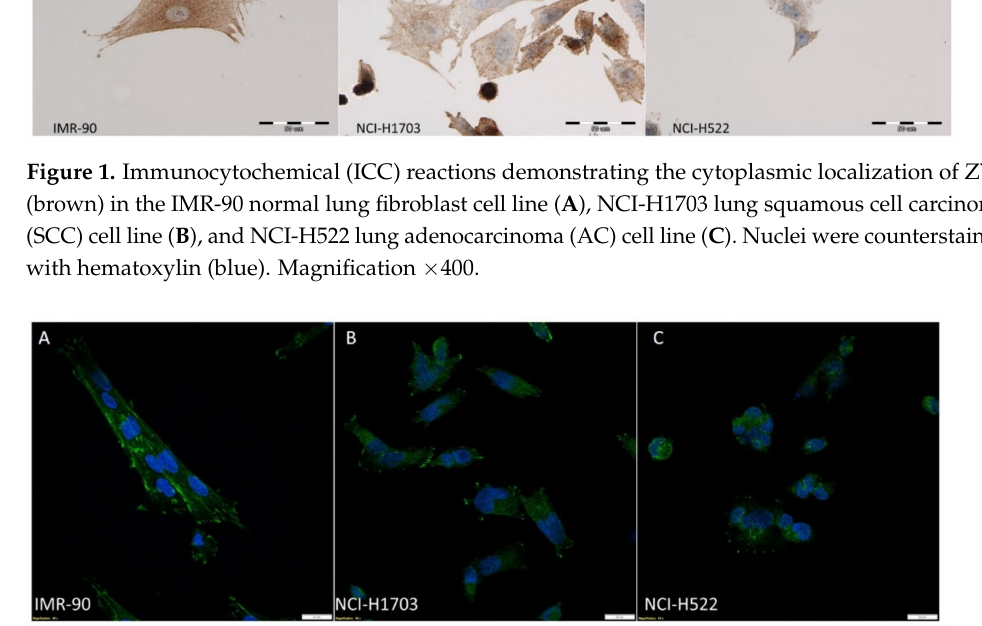
Figure 2. Immunofluorescence (IF) images taken by confocal microscopy showing ZYX expression (green) in the IMR-90 normal lung fibroblast cell line ( A ), NCI-H1703 lung SCC ( B ) and NCI-H522 lung AC ( C ). Nuclei were counterstained with DAPI (blue). Magnification × 600.